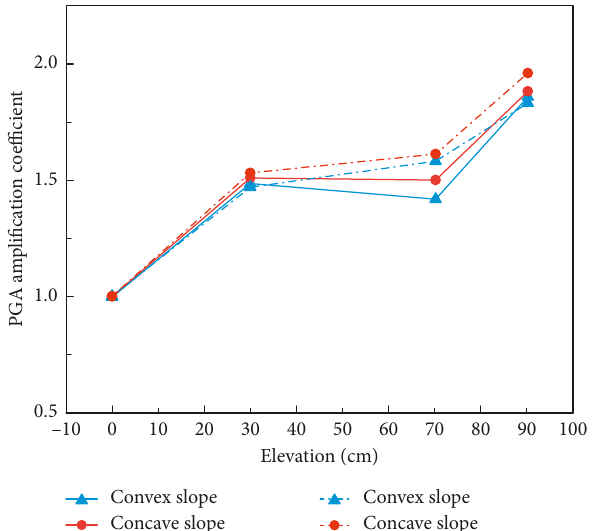
Figure 15: PGA amplification coefficients under condition ELC-1 and SIN-1.